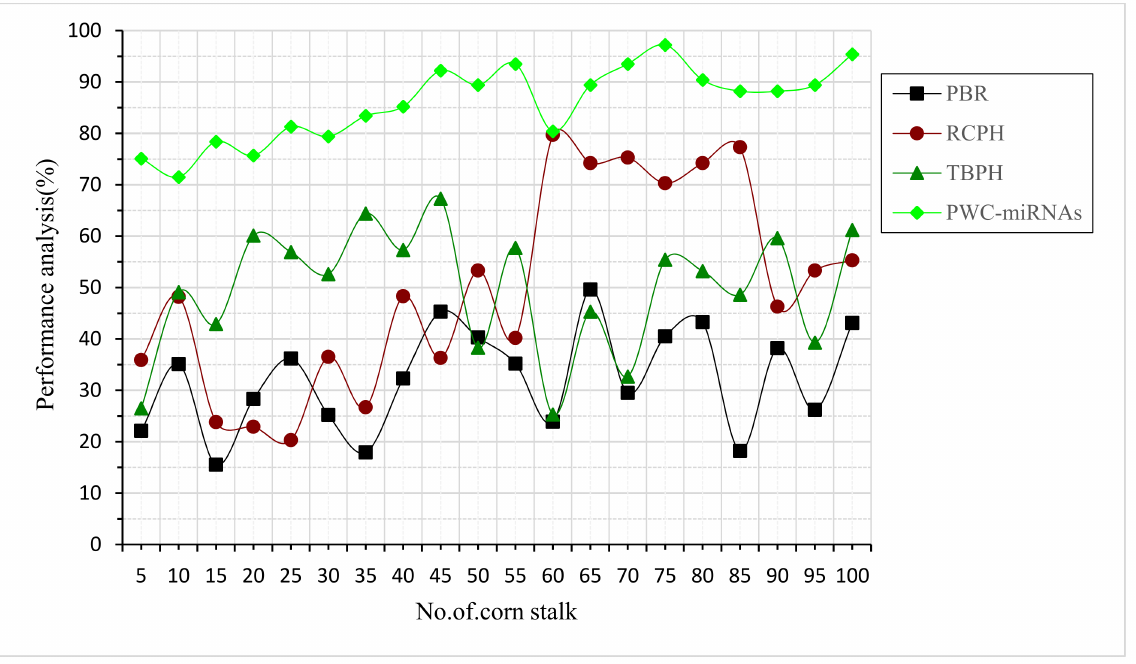
Figure 3. Sugar-content performance analysis of corn